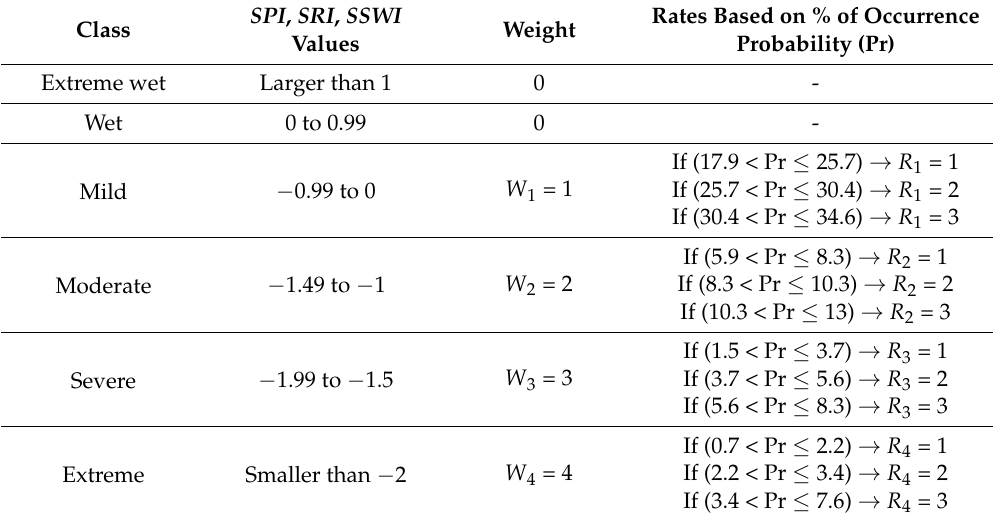
Table 2. Six drought classes and weight and rate assigned to each drought class based on drought severity and drought occurrence probability, respectively. SPI, Standardized Precipitation Index; SRI, Standardized Runoff Index; SSWI, Standardized Soil Water